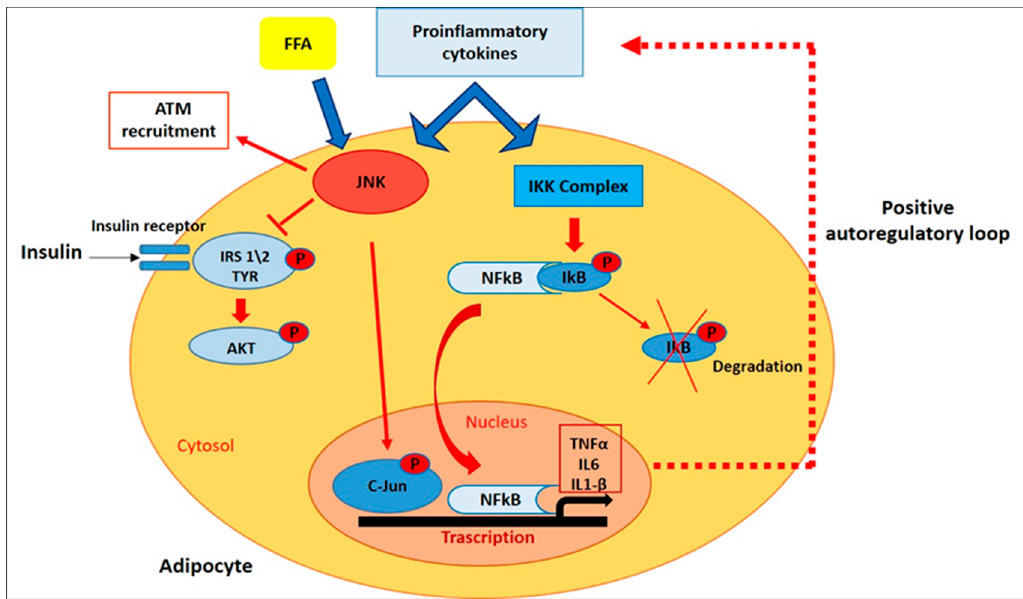
Figure 3. Intracellular Pathways that Control Inflammatory Signaling. In adipose tissue of obese patients, FFAs and proinflammatory cytokines mediate the activation of JNK and NF-kB pathways, which in turn promote insulin resistance and the transcription of target genes encoding for inflammatory mediators.